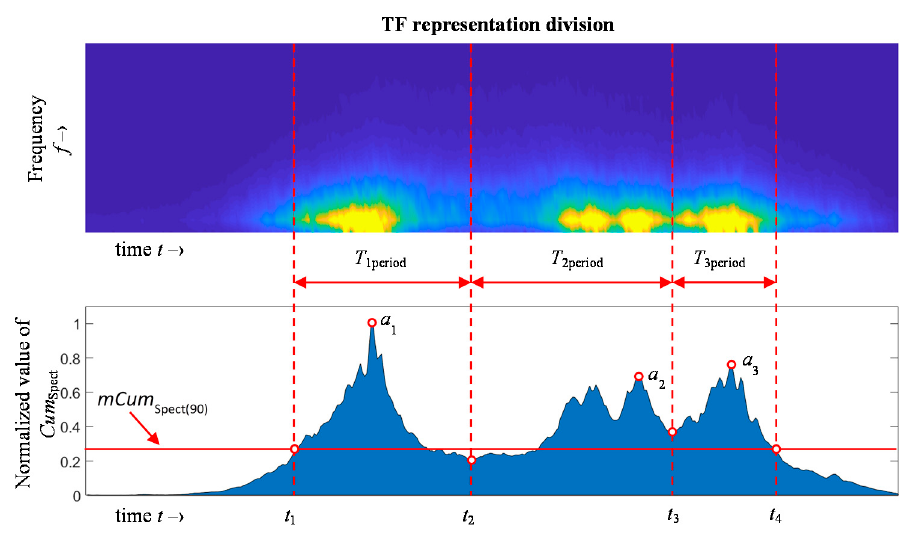
Figure 9. Visualization of the BN TF_S spectrogram distribution and the 1D instantaneous cumulative